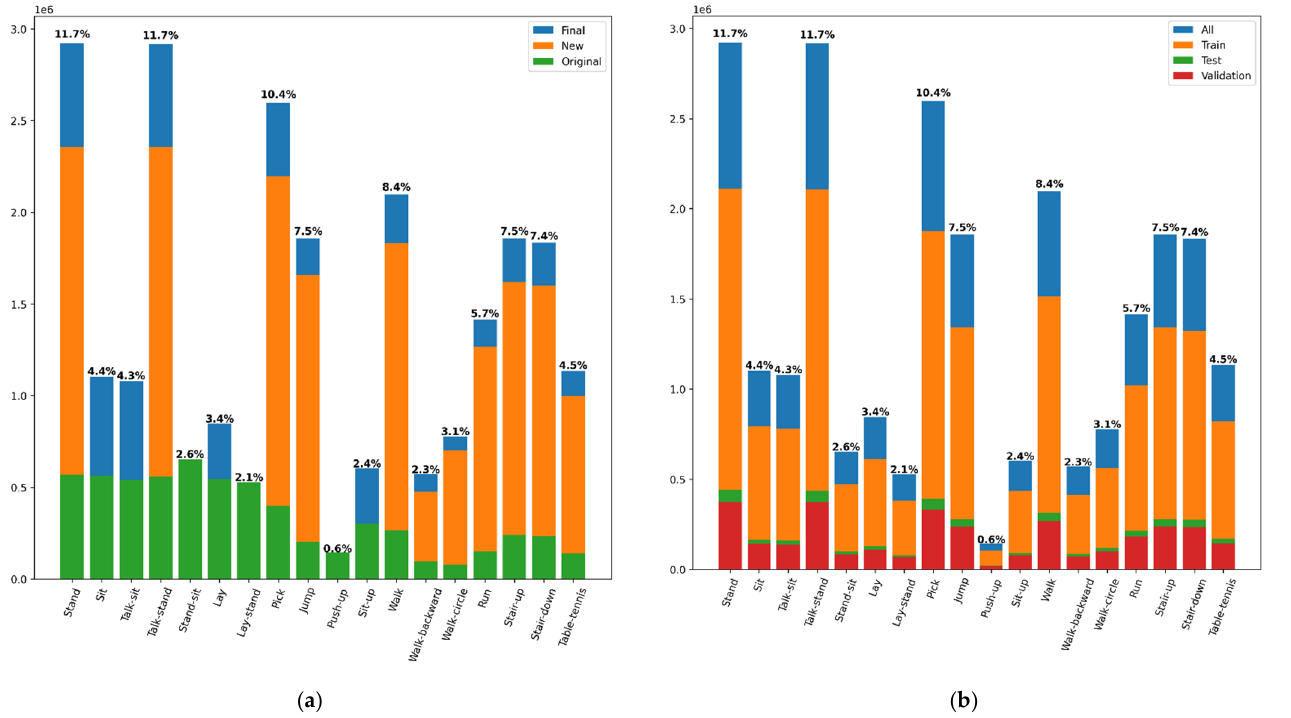
Figure 2. Distribution of examples by classes: ( a ) Distribution of examples by individual classes before and after the data augmentation process; ( b ) distribution of examples by individual classes into training, testing, and validation datasets. Table 4. Optimized hyperparameter